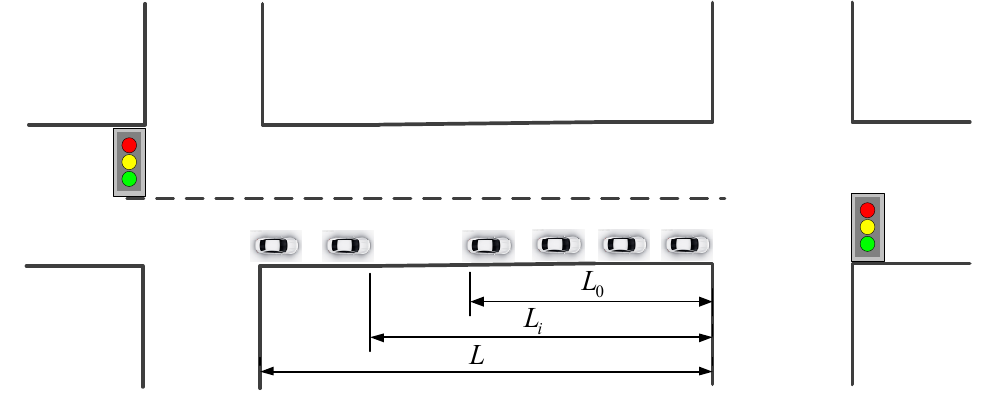
Figure 3. Schematic diagram of the intersection.